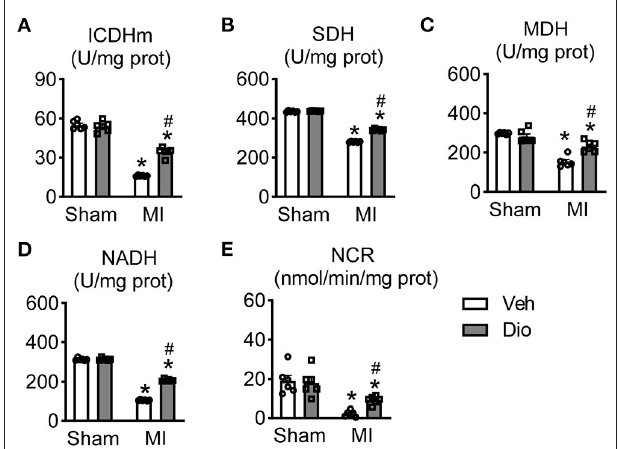
FIGURE 4 | Effect of dioscin on the activities of mitochondrial KREB cycle and respiratory chain enzymes in hearts after MI. The key enzymes of tricarboxylic acid cycle (TCA) of (A) isocitrate dehydrogenase (ICDH; U/mg prot), (B) succinate dehydrogenase (SDH; U/mg prot), and (C) malate dehydrogenase (MDH; U/mg prot). The measureable of respiratory chain enzymes of (D) nitotinamide adenine dinucleotide dehydrogenase (the complex I, NADH; U/mg prot) and (E) cytochrome c-oxidase (the complex III, NCR; nmol/min/mg prot). n = 6. Data are mean ± SEM. * P < 0.05 vs. sham group, # P < 0.05 vs. MI